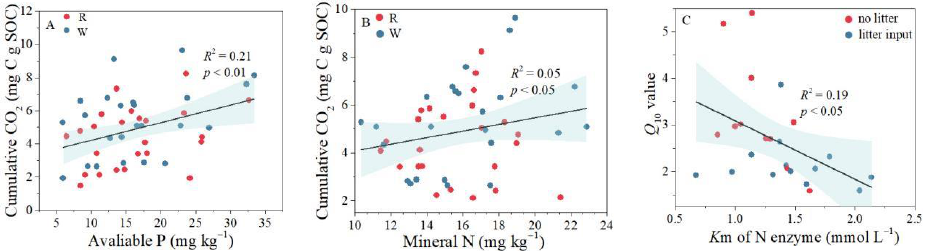
Figure 5. Relationships between the cumulative CO 2 (38 – 97 days) and available P ( A ) and mineral N ( B ) after 97 days incubation. The relationship between K m of N enzyme and Q 10 ( C ) in the second stage. R and W represent room temperature and warming temperature, respectively.